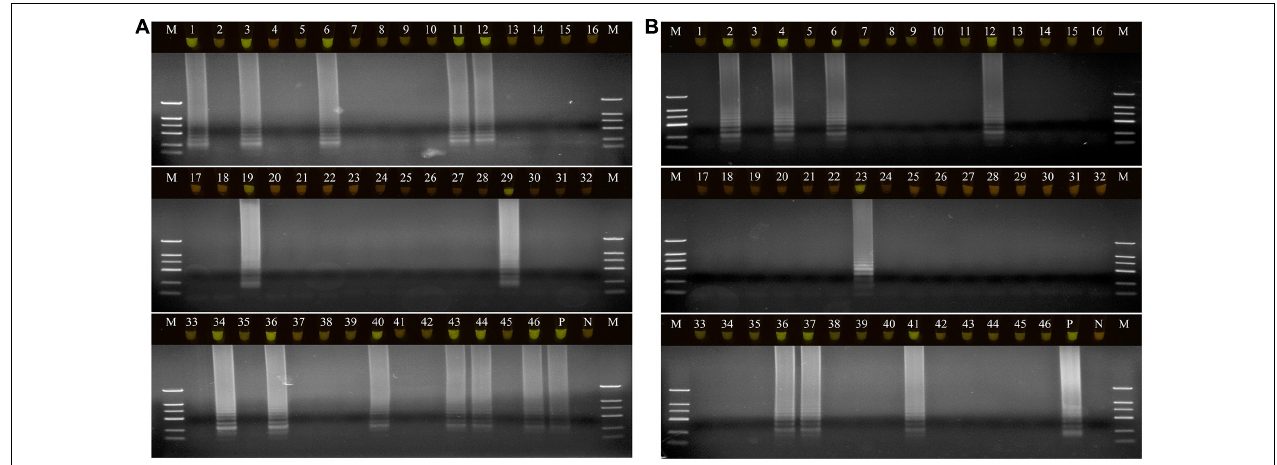
FIGURE 5 | The detection results of Pseudomonas aeruginosa by loop-mediated isothermal amplification (LAMP) in Fuzi and rhizosphere soil samples. (A) The detection results of Pseudomonas aeruginosa by LAMP in Fuzi samples. Lanes 1–46: different Fuzi samples. (B) The detection results of Pseudomonas aeruginosa by LAMP in Fuzi rhizosphere soil samples. Lanes 1–46: different Fuzi rhizosphere soil samples. (Up) LAMP products visualized with gelgreen. Under daylight, positive reactions are shown by bright green color, and negative reactions are dark red color. (Down) LAMP products determined by agarose gel electrophoresis. Lane M: